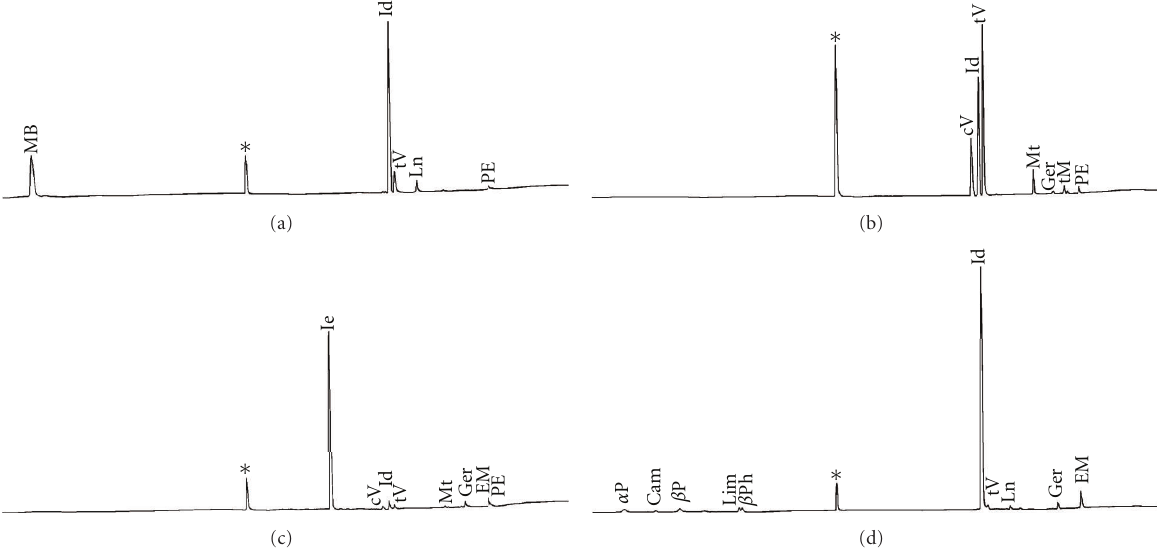
Figure 1: GC chromatograms from GC-MS analyses of male hindgut extracts. MB: 2-methyl-3-buten-2-ol; Id: ipsdienol; Ie: ipsenol; cV: cis -verbenol; tV: trans- verbenol; Ln: lanierone; Mt: myrtenol; Ger: geraniol; tM: trans -myrtanol; EM: E -myrcenol; PE: 2-phenyl ethanol; ∗ : internal quantification standard, heptyl acetate (C 7 Ac) amount varies between sample—see the following (for full list of identified compounds and quantities, see Table 4). (a) I. avulsus 15 males: C 7 Ac is 100 ng. (b) I. calligraphus 4 males: C 7 Ac is 1000 ng. (c) I. grandicollis 5 males: C 7 Ac is 100 ng. (d) I. pini 10 males: C 7 Ac is 1000 ng.